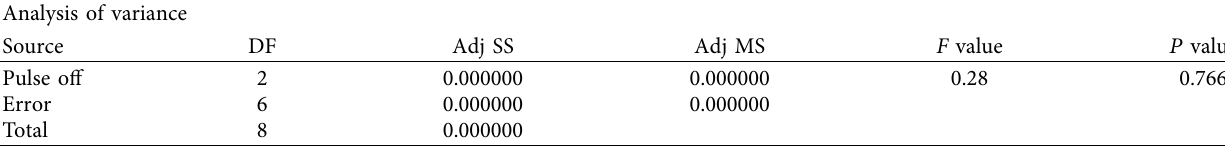
Table 12: One-way ANOVA: MRR vs. pulse-off time for aluminium.